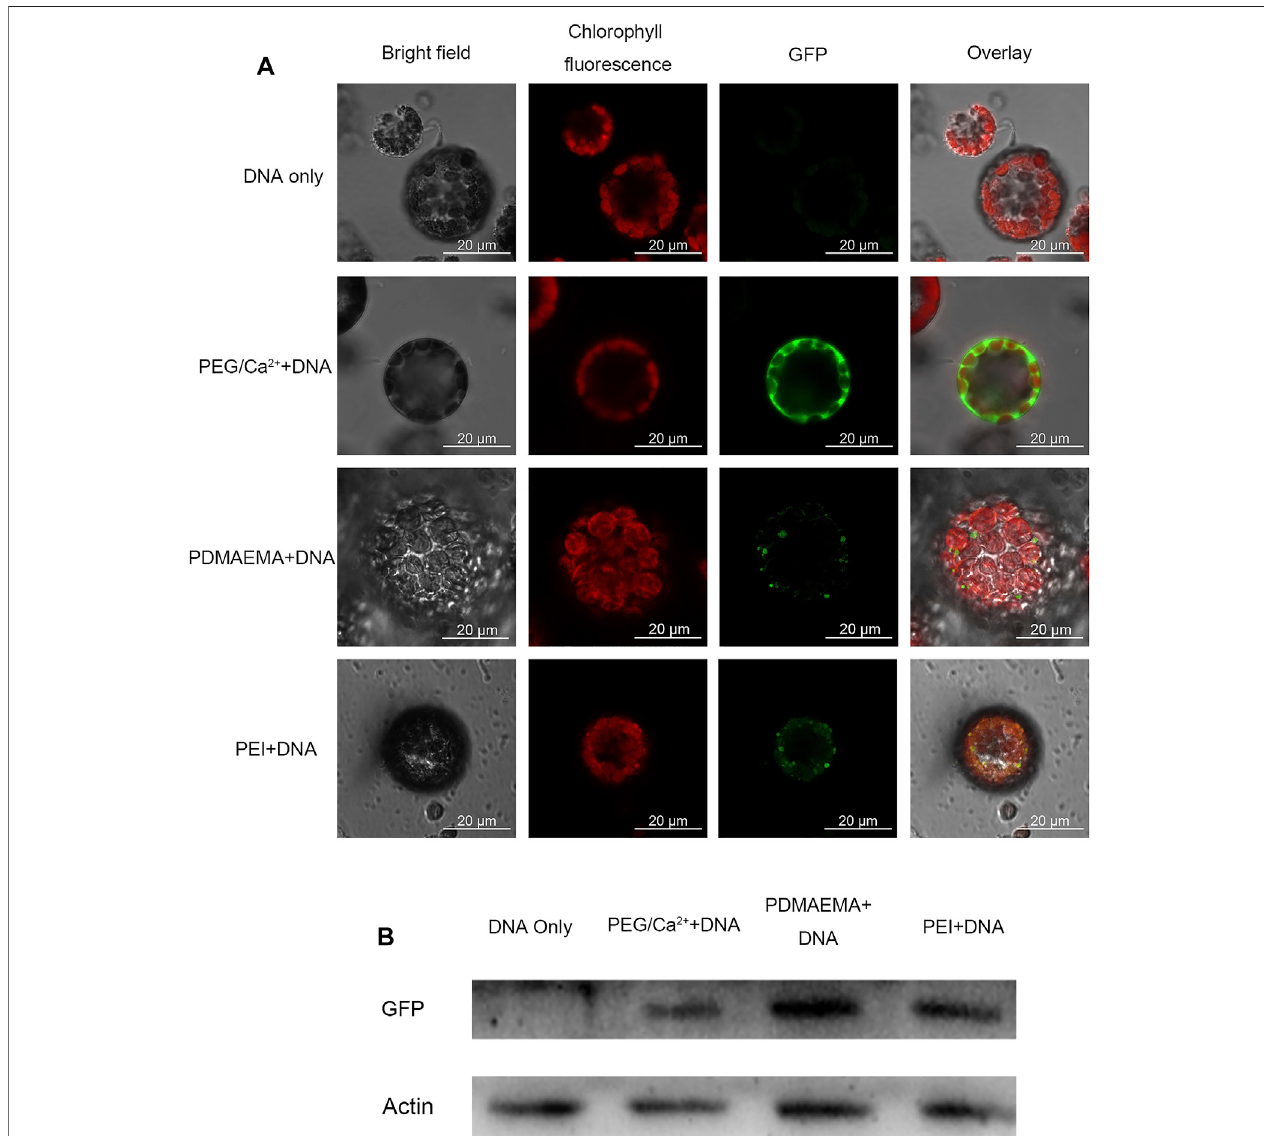
FIGURE3| GFPexpressionimagingin Arabidopsisthaliana protoplast. (A) Confocalmicroscopewasusedtoimagethe Arabidopsisthaliana protoplastincubated with DNA only as a negative control, PEG/Ca 2+ as a positive control, PDMAEMA + DNA (N/P ratio of 15:1), and PEI + DNA (N/P ratio of 15:1). GFP fl uorescence images were captured with 488 nm laser excitation and 539 nm emission wavelengths. Chlorophyll auto fl uorescence images were captured with 633 nm laser excitation and 691 nm emission wavelengths. Scale bar, 20 μ m. Protoplasts were incubated with PEG/Ca 2+ for 15 min and washed with W5 solution to remove PEG. Then, protoplasts were resuspended with W5 solution in a 1.5-mL tube for another 12 h in the dark. The protoplasts were incubated with PDMAEMA + DNA or PEI + DNA directlyfor 12h. (B) Western blot oftheGFP expression level of Arabidopsisthaliana protoplasts incubated withDNA only,DNA-PEG/Ca 2+ ,PDMAEMA + DNA,and PEI +